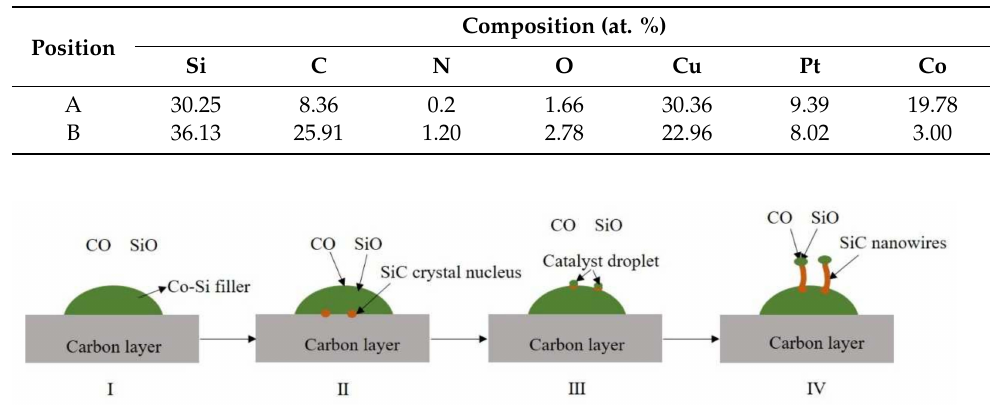
Figure 12. Schematic diagram of SiC nanowire